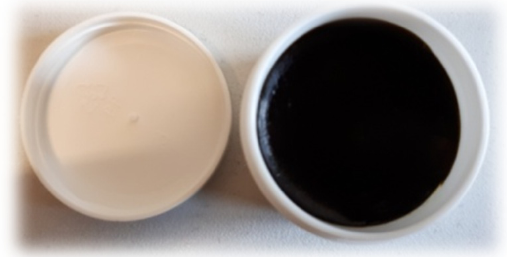
Figure 1. Hemp extract ( Cannabis sativa L.) [own photography].